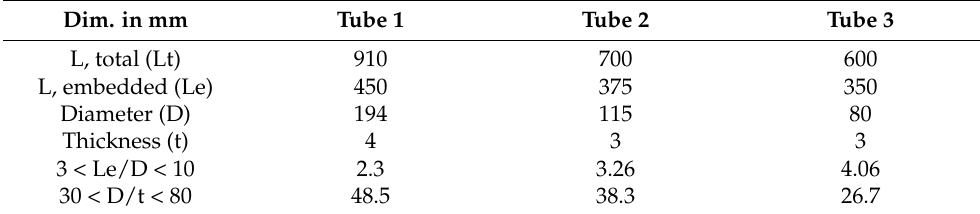
Table 4. Tube dimensions and PISA